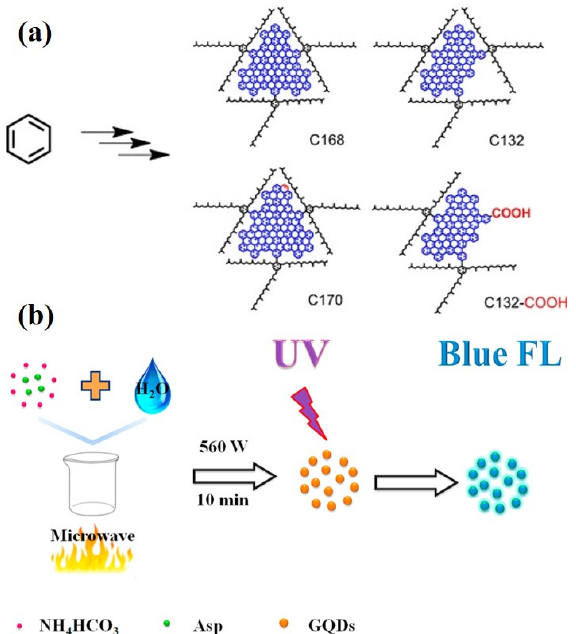
Figure 9. ( a ) Stepwise Organic Methods: schematic structure of colloidal graphene quantum dots synthesized by stepwise solution chemistry control with a graphene core containing 168, 132, 170 and 132 conjugated carbon atoms. Reprinted with permission from Ref. [113]. Copyright 2013, American Chemical Society. ( b ) Microwave-Assisted Methods: schematic illustration of the preparation process for the GQDs. Reprinted with permission from Ref. [116]. Copyright 2016, Elsevier.